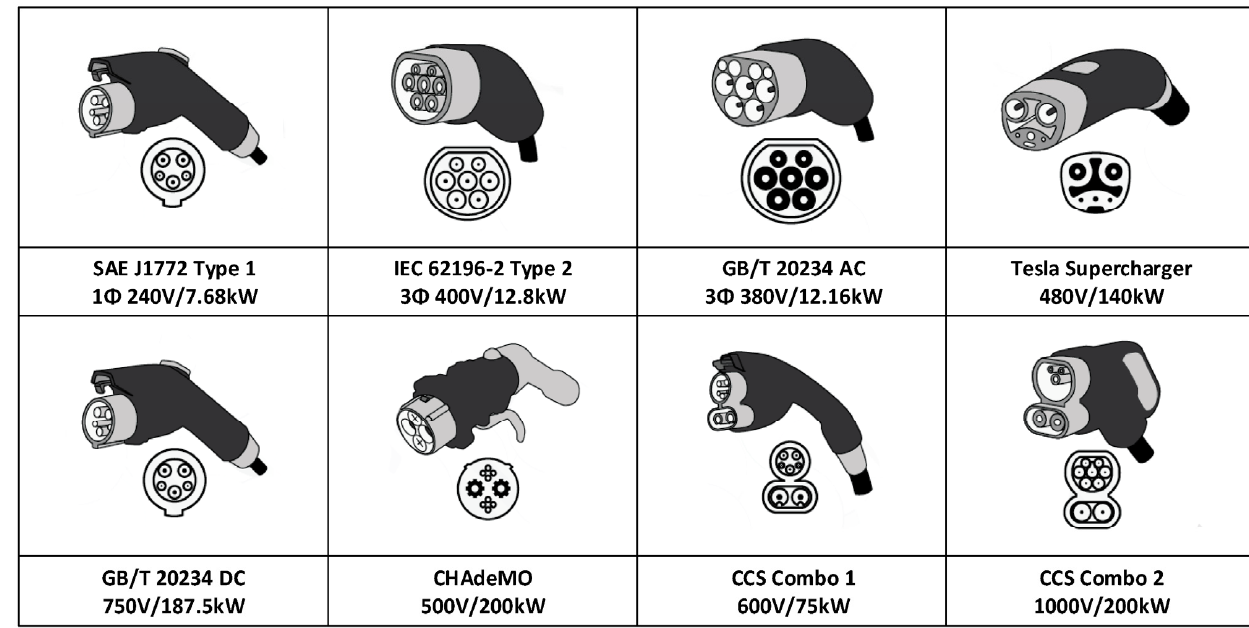
Figure 2. Global male and female battery charger connectors [81].